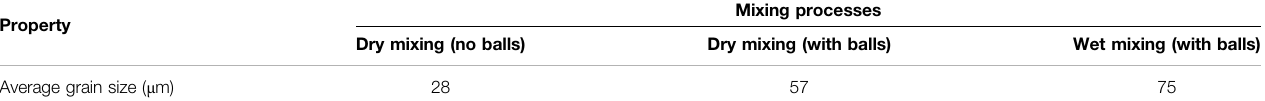
TABLE 4 | The average grain size of UO 2 pellets mixed in different processes.